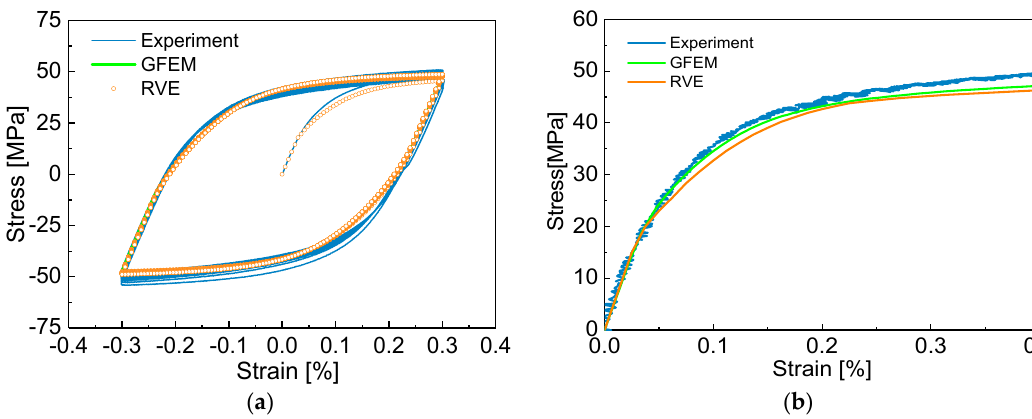
Figure 7. Stress-strain curve of tension-compression cyclic loading and monotonic tension curve by test and crystal plasticity simulation with the global finite element model (GFEM) containing 36,000 grains as the same size of the thin-walled tube specimen used in the experiments and the RVE containing 125 grains: ( a ) cyclic stress-strain curve; ( b ) monotonic tension curve. Table 2. The material constants of single crystal aluminum.